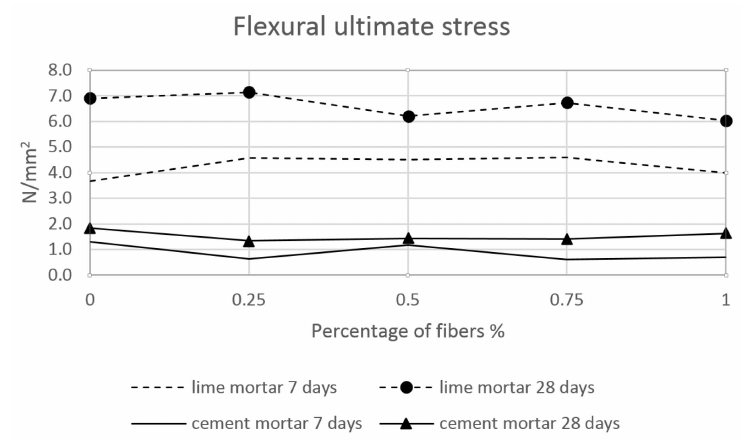
Figure 9. Flexural test results.